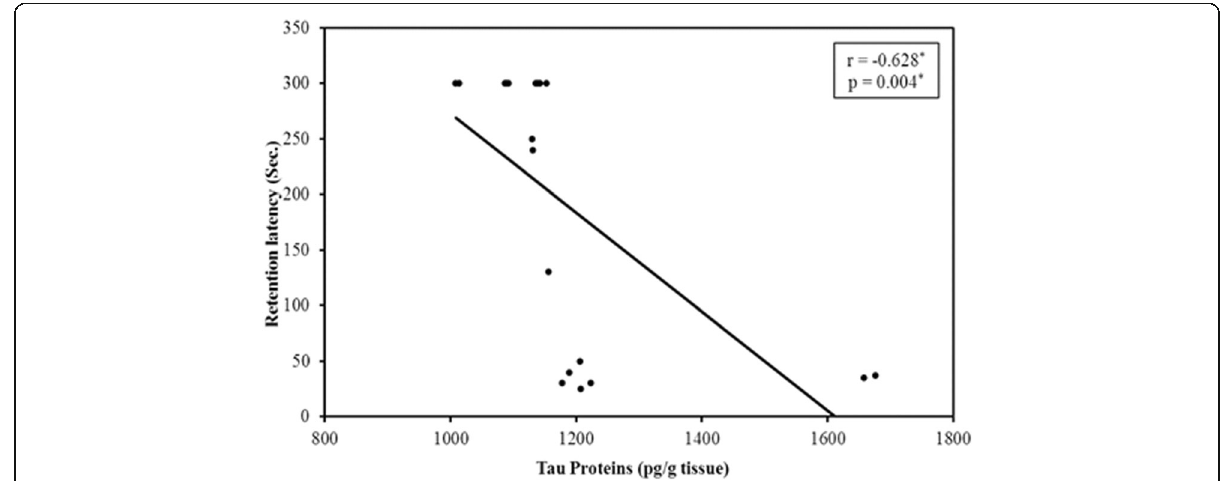
Fig. 8 Correlation between tau proteins (pg/g tissue) with retention latency (seconds) in the total samples (groups I, II, and